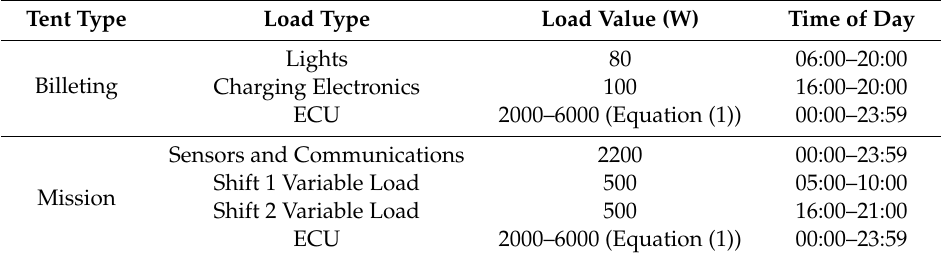
Table 1. Typical fabric shelter power load parameters. ECU: environmental control